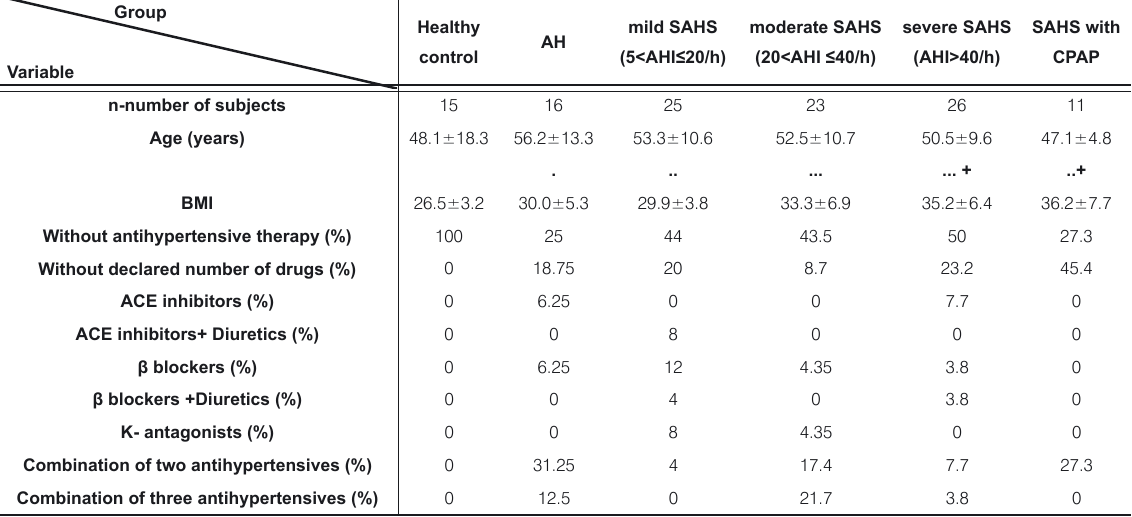
Table 1. Distribution of 116 subjects into 6 groups with basic anthropometric data and presence or absence of antihypertensive